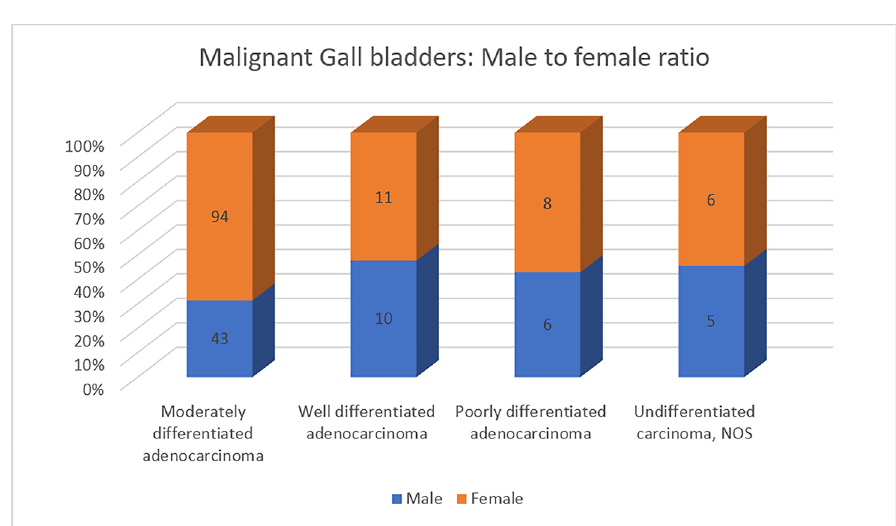
Figure 6. Male to female ratio for malignant gall bladder diseases